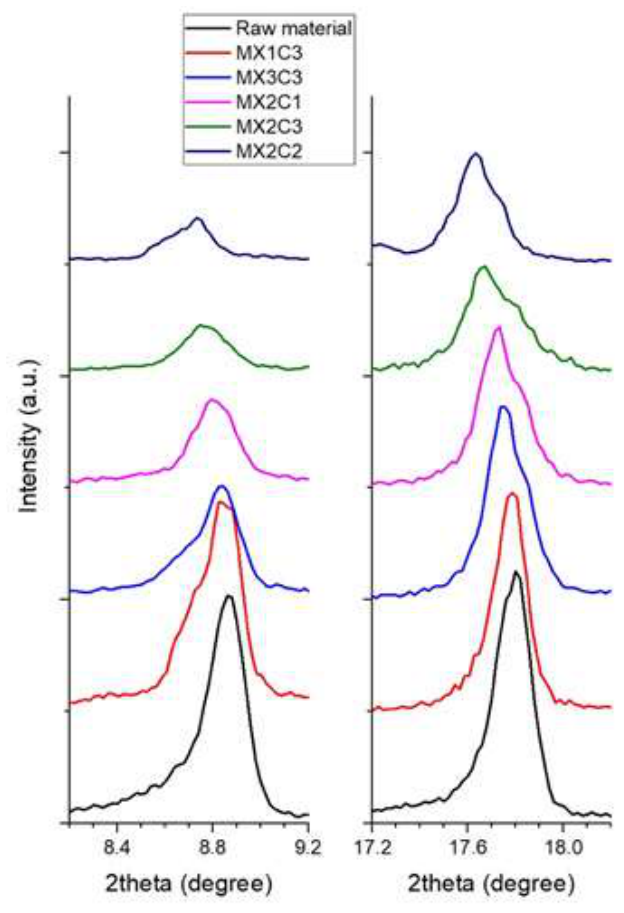
Figure 3. The XRD pattern of the C 16 -length surfactant (HAD) at 2 θ = 8.86 ◦ and 2 θ = 17.62 ◦ values. Sonication results of mica samples with reduced charge density and swelling property, evaluated according to particle thickness by time ( c ), particle lateral length ( a ) and particle dimension change, and results are given in Tables 5–9 along with the change of aspect ratio AR (a / c) which is the ratio of a and c